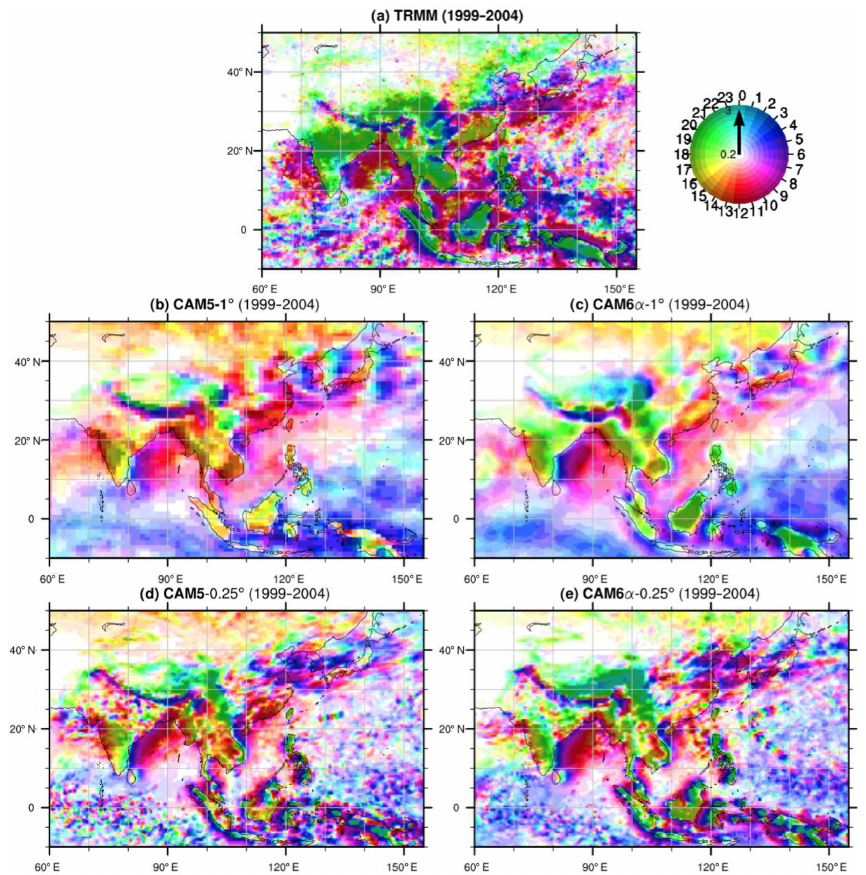
Figure 13. Diurnal cycle of precipitation in June (6-year average for 1999–2004) of (a) TRMM, (b) CAM5-1 ◦ , (c) CAM6 α -1 ◦ , (d) CAM5- 0.25 ◦ and (e) CAM6 α -0.25 ◦ . The local time peak of the diurnal cycle is shown in color on the color wheel. The intensity of the color is the amplitude of